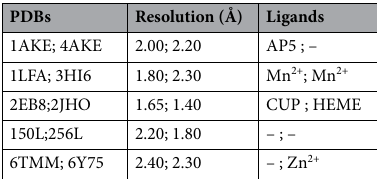
Table 1. Test cases